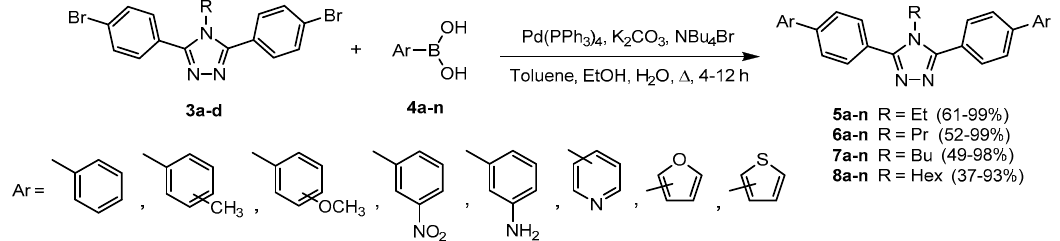
Table 3. The synthesis of 3,5-bis(biphenyl-4-yl)-4-butyl-4 H -1,2,4-triazole ( 7a ) in IL.